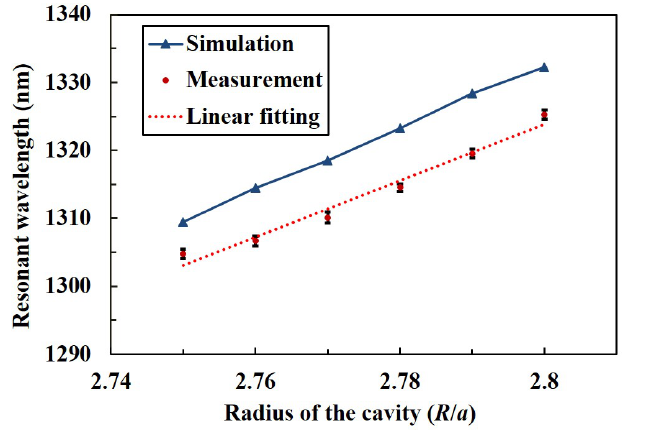
Figure 11. Measured and theoretically estimated lasing wavelengths of WGM as a function of R . Fabricated a and r were kept approximately constant at 385 nm and 0.29 a . (reprinted with permission from reference [26],